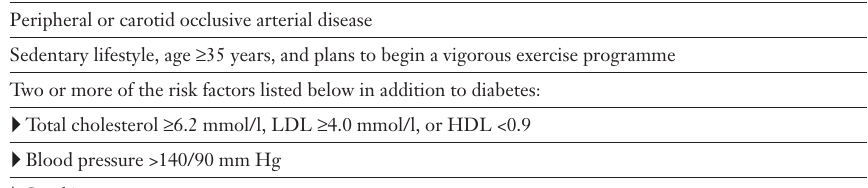
Indications for cardiac testing in diabetic